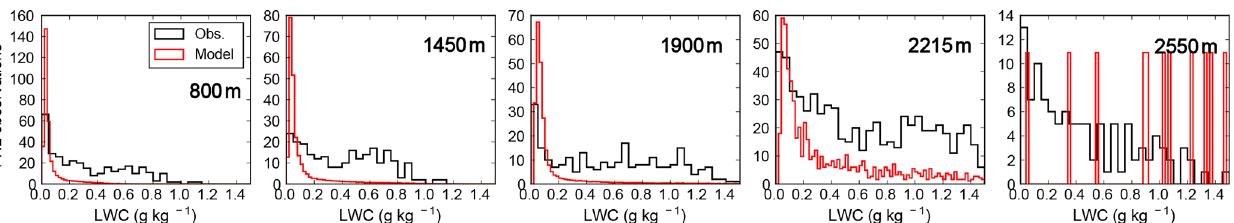
Figure 5. The dry size distributions (out of cloud) observed by the aircraft from a combination of PCASP (black) and SMPS (grey) instru- ments are shown at different altitudes compared to the model Aitken (orange) and accumulation mode (red) number concentrations, with the total shown as a red dotted line. The simulated coarse mode is not shown. All data shown are out-of-cloud data at standard temperature and pressure. The simulated data are a mean over the domain at 12:00UTC. Only aircraft data from straight-and-level legs at the specified altitude are shown.